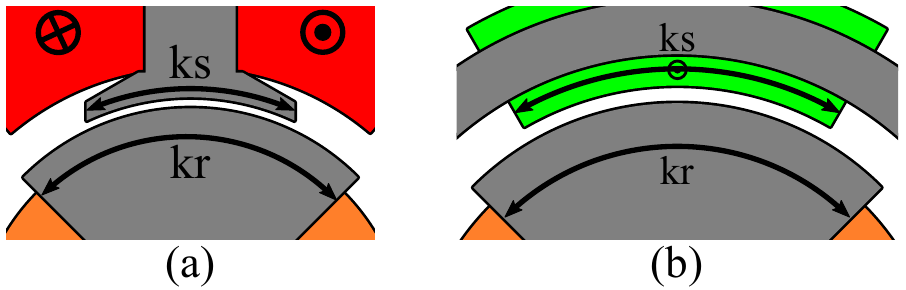
Figure 2. Optimized resolver parameters ( a ) for slotted resolvers and ( b ) for slotless resolvers. For each kr and ks , the obtained EMFs were studied in order to find the combination with the least THD. Additionally, for each parameter combination, different skew values were applied and simulated to eliminate the existent lower frequency harmonics and, hence, improve the THD. Consequently, the best parameter combination and the best skew value were selected for each topology. The parameter combination offering the best EMF without skew and with skew may not be the same as demonstrated in the next